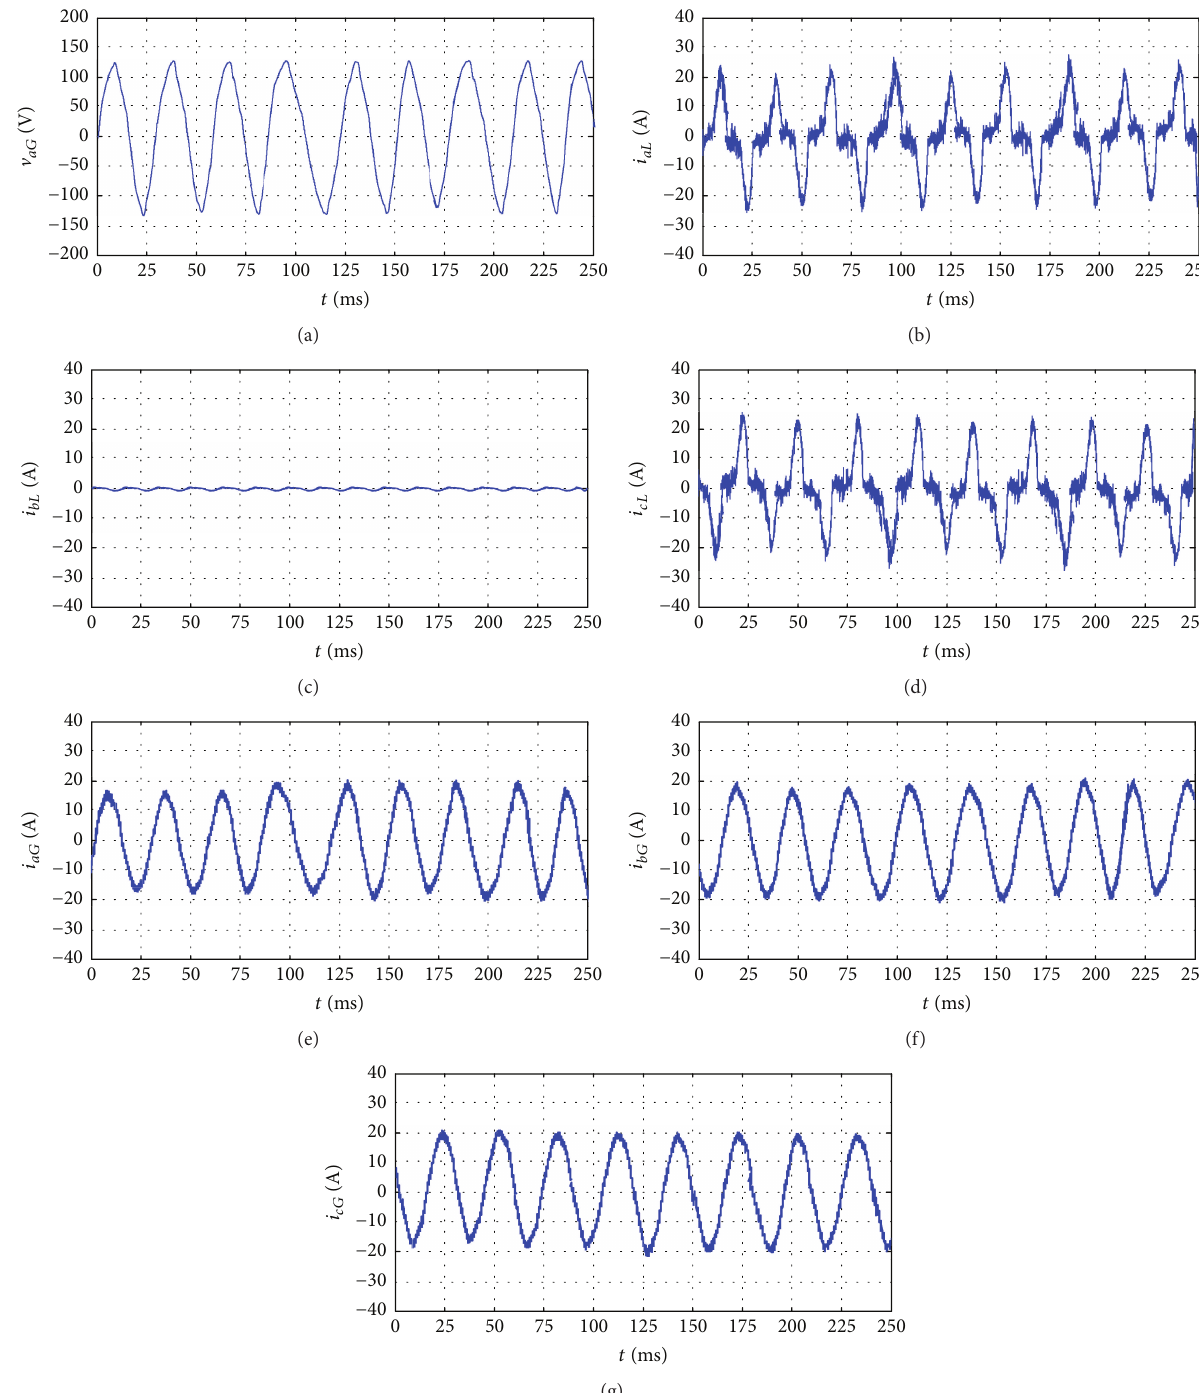
Figure 8: Experimental results of the proposed system with unbalanced nonlinear load: (a) phase voltage V 𝑎𝐺 of the wind generator; (b) nonlinear load current 𝑖 𝑎𝐿 ; (c) nonlinear load current 𝑖 𝑏𝐿 ; (d) nonlinear load current 𝑖 𝑐𝐿 ; (e) line current 𝑖 𝑎𝐺 of the wind generator; (f) line current 𝑖 𝑏𝐺 of the wind generator; (g) line current 𝑖 𝑐𝐺 of the wind